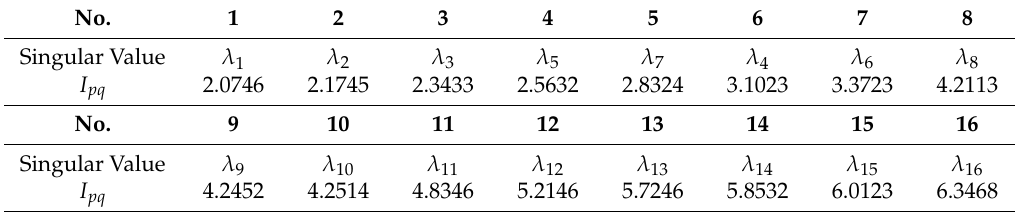
Table 4. SVs are listed in ascending order based on statistical information.